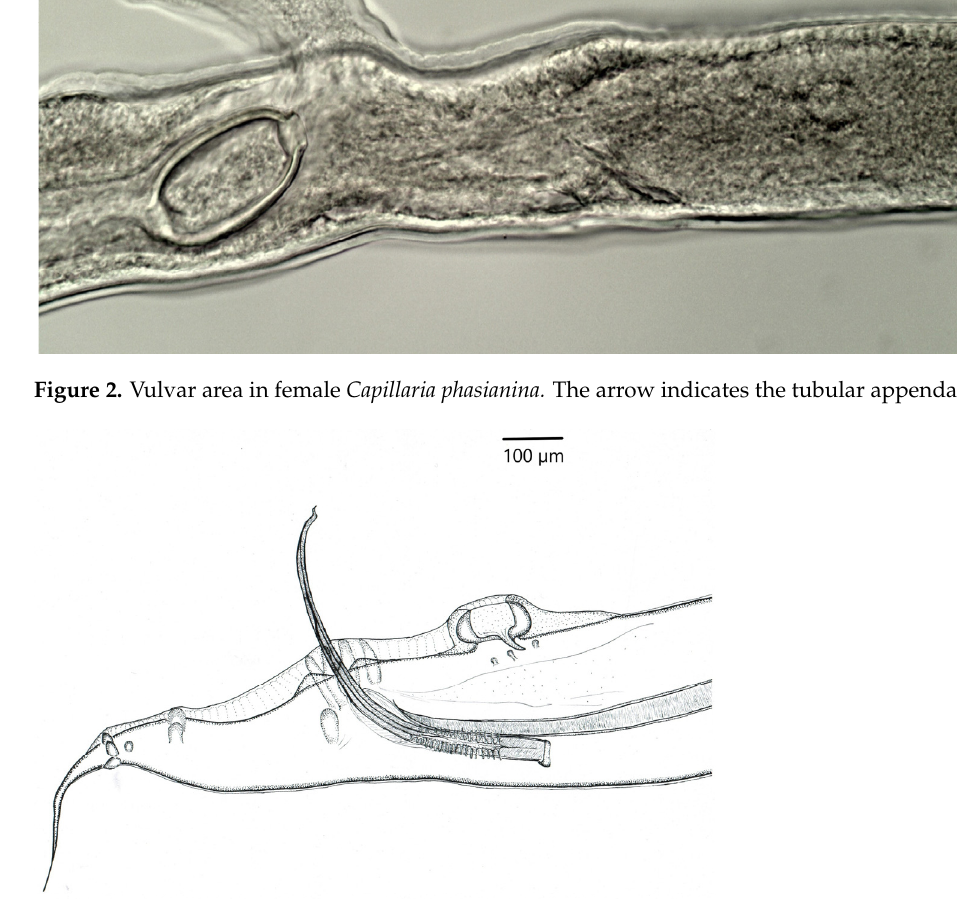
Figure 3. Posterior end of body of male Heterakis gallinarum ; lateral view